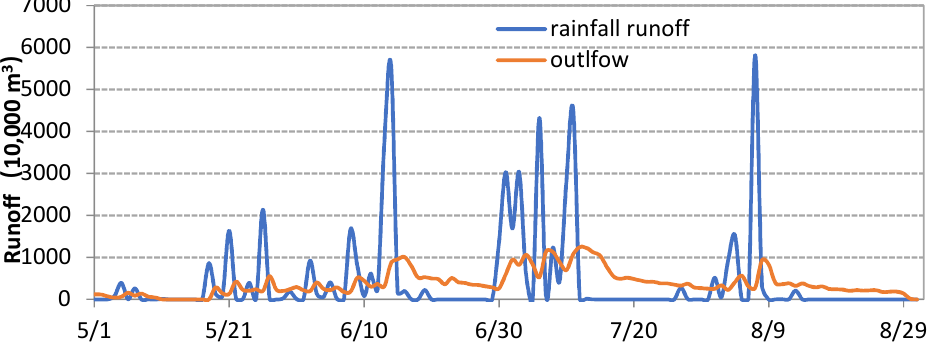
Figure 10. Comparison between daily rainfall runoff and outflow in the wet season (wet year, 5%).